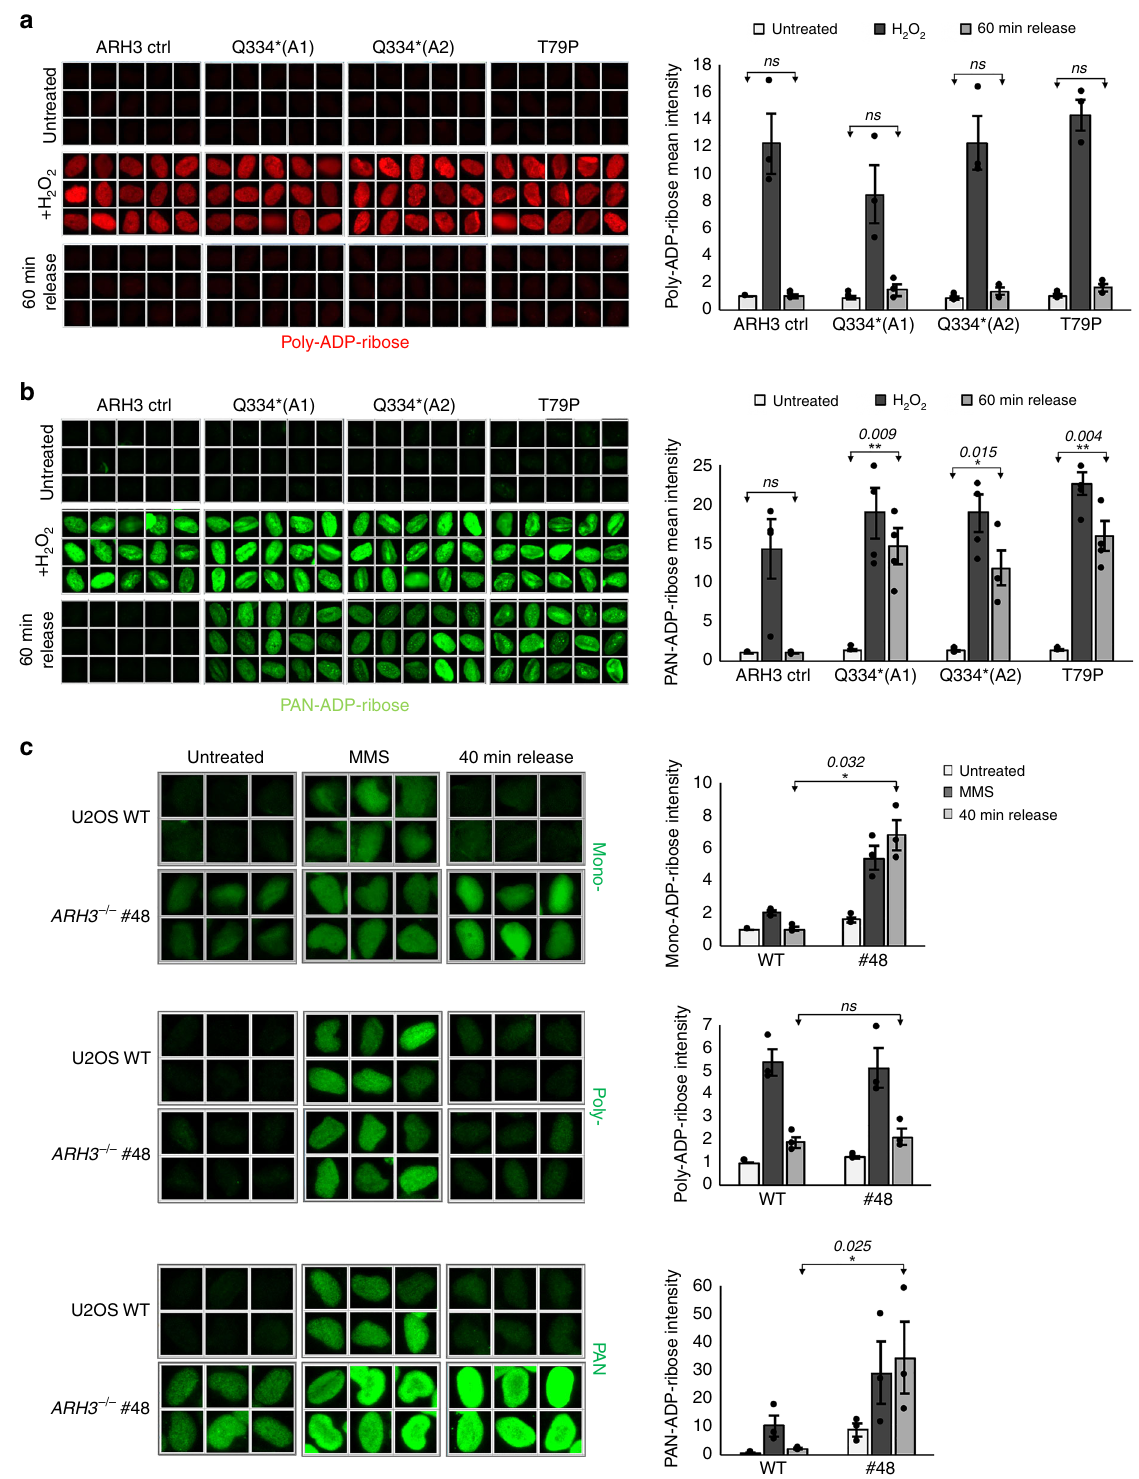
Fig. 2 ARH3-defective cells accumulate mono(ADP-ribose) in chromatin during the repair of exogenous DNA damage. Levels of ADP-ribosylation were measured by indirect immuno fl uorescence in control and patient fi broblasts before, immediately after 10 min treatment with 150 μ M H 2 O 2 on ice, and after a 60 min repair period in H 2 O 2 -free medium. Cells were pre-extracted with detergent prior to fi xation and staining with an anti-poly-ADP-ribose antibody ( a ) or an anti-PAN-ADP-ribose binding reagent that detects both mono- and poly-ADP-ribose ( b ). c Levels of ADP-ribosylation were analysed by indirect immuno fl uorescence in wild-type and ARH3 − / − U2OS cells before, immediately after 20 min treatment with 0.2 mg/ml MMS, and after a 40 min repair period in MMS-free medium. Cells were pre-extracted with detergent prior to staining with anti-mono-ADP-ribose binding reagent, anti-poly-ADP-ribose antibody, or anti-PAN-ADP-ribose binding reagent. Representative ScanR images and quanti fi cation using ScanR software for a , b , and c are shown. Data are the mean ± SEM of at least three biologically independent experiments; n = 3 for a , c , and n = 4 for b . Statistical analysis (two-tailed t -test) is indicated (** P < 0.01; * P < 0.05; ns not signi fi